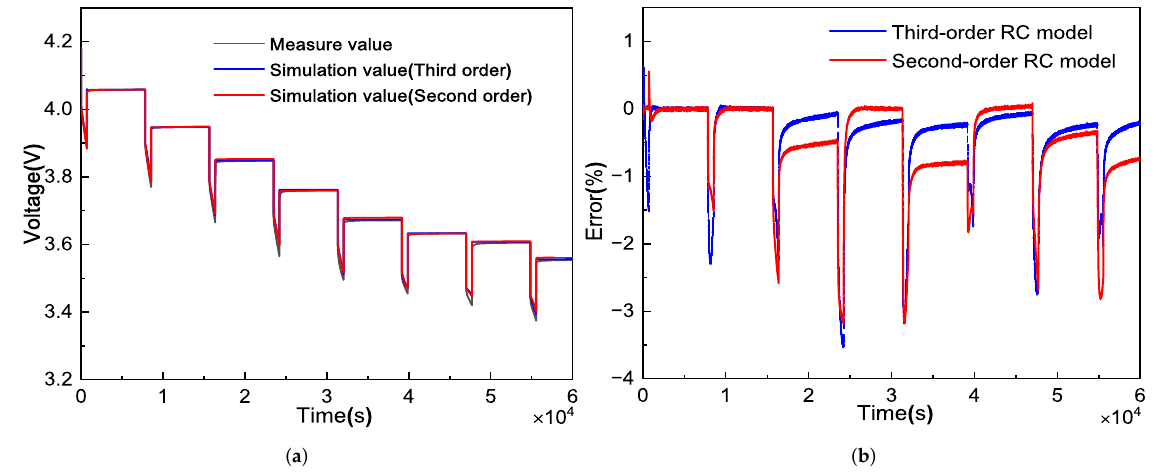
Figure 5. Voltage comparison and its error curve under the mode of pulse discharge: ( a ) Voltage, ( b )